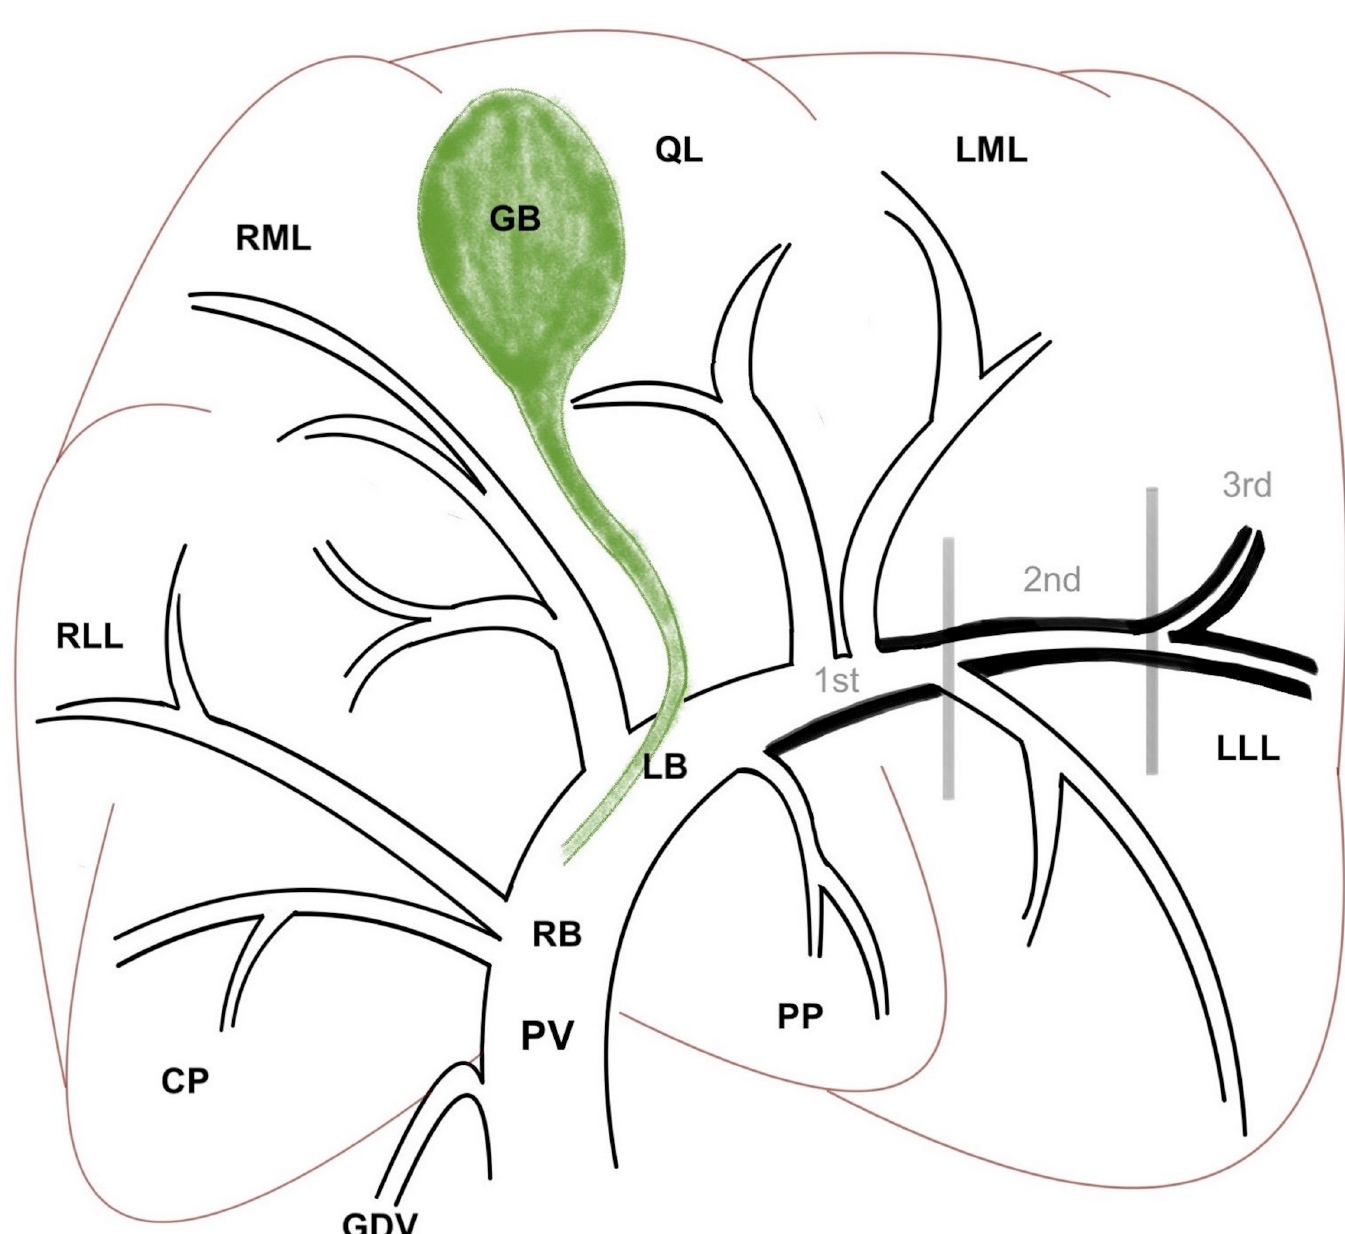
Fig 2. Schematic drawing of the intrahepatic portal system. Dorsal plane image showing the short right (RB) and long left branch (LB) which are further dividing into lobe and segmental branches. An example of the periportal halo is given along the left lateral lobe branch and is presented as thickened black line. Classification of the halo distribution into first (1 st ), second (2 nd ) and third (3 rd ) generation is marked with vertical lines. Abbreviations: PV, portal vein; GDV, gastroduodenal vein; CP, caudate process of caudate lobe; RLL, right lateral lobe; RML, right medial lobe; QL, quadrate lobe; LML, left medial lobe; LLL, left lateral lobe; PP, papillary process of caudate lobe; GB, gall